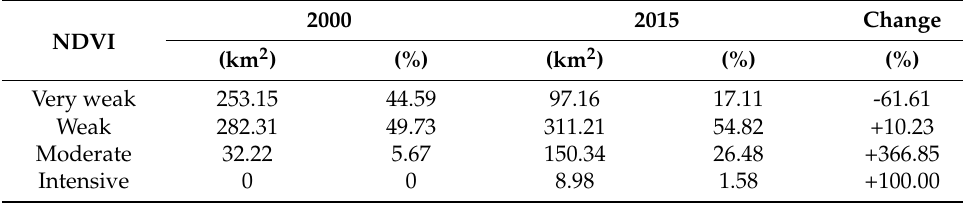
Table 3. Distribution of NDVI classes for 2000 and 2015. Ixtacamaxtitlan, Puebla, M é xico.